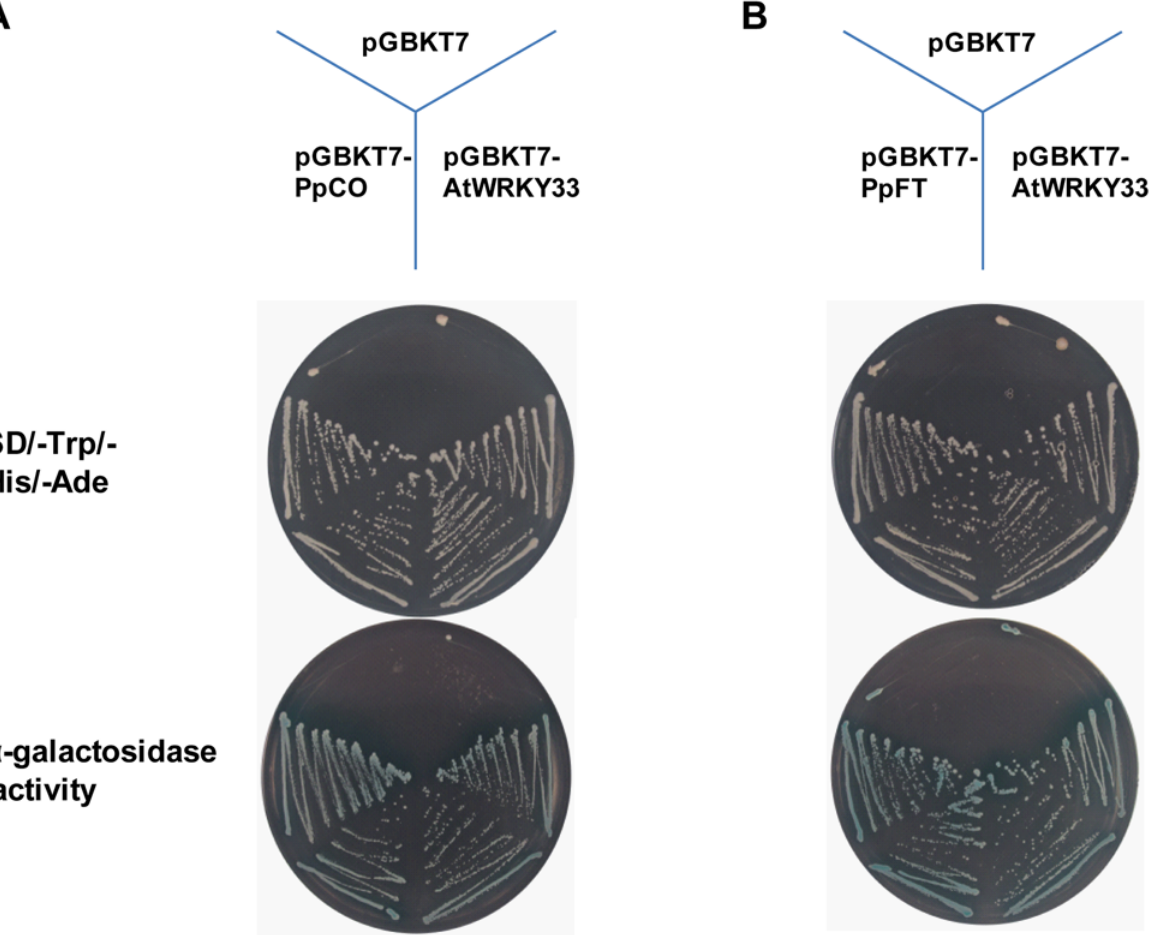
Fig 3. Transcriptional activation analysis of PpCO and PpFT in yeast. PpCO and PpFT were fused with the GAL4 DNA-binding domain and expressed in yeast strain AH109. Transcriptional activation activities were monitored by the detection of yeast growth and α -galactosidase activity. pGBKT7 and pGBKT7-AtWRKY33 were used as negative control and positive control,